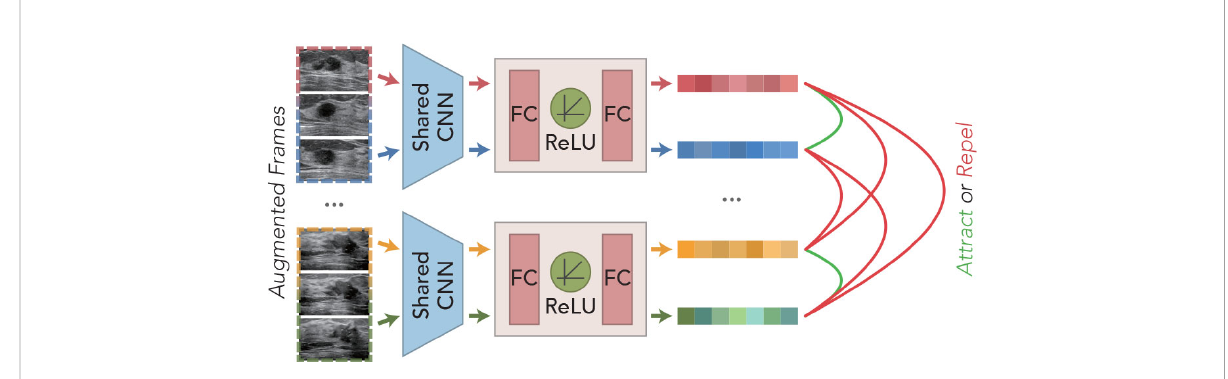
FIGURE 3 Schematic illustration of the predecessor task for the contrast learning